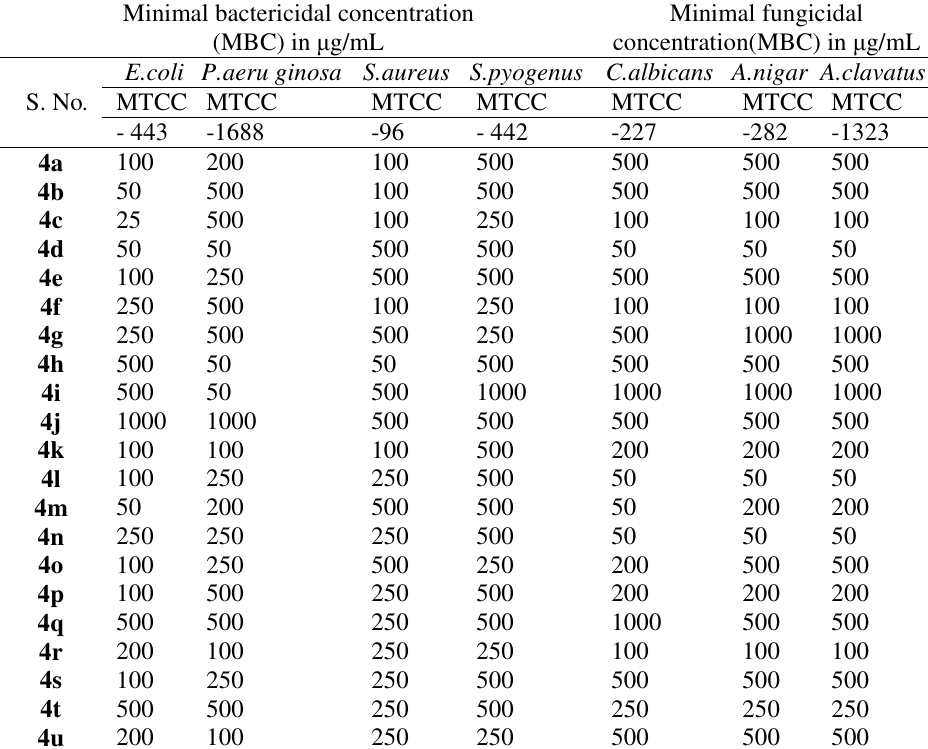
Table 2. Antibacterial and antifungal